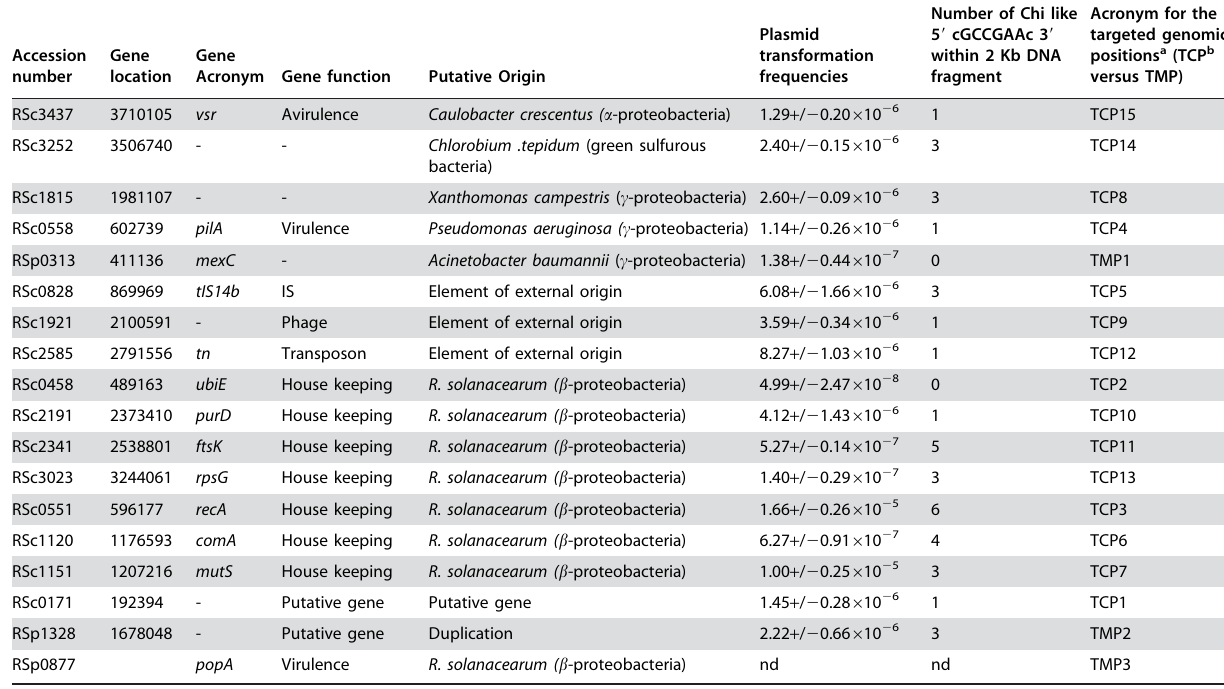
Table 1. Origin, properties of Ralstonia solanacearum (GM1000) genes used in this study as plasmid or genomic donor DNA; plasmid transformation frequencies and number of Chi-like sequences detected within the 2 kb long DNA positions. .. ... .... ... ... .... ... ... .... ... ... .... ... ... .... ... ... .... ... ... .... ... ... .... ... ... .... ... ... .... ... ... .... ... ... .... ... ... .... ... ... .... ... ...